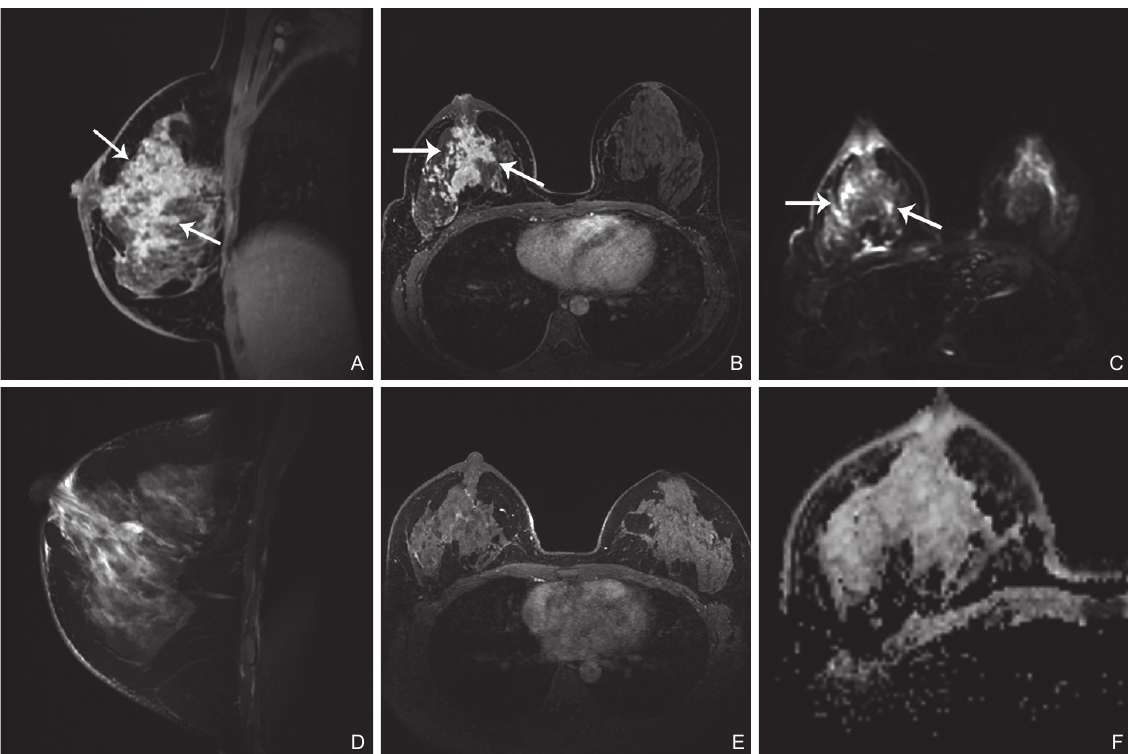
D E Figure 3 A 57-year-old women with multiple right breast lesions that underwent percutaneous biopsy, revealing invasive breast cancer. Before neoadjuvant chemotherapy, CE-MRI (A and B) showed area of clumped enhancement (arrows) with regional distribution, and DWI-MRI (C) showed heterogeneous masses (arrows) of right breast. After completion of neoadjuvant chemotherapy, CE-MRI (D and E) showed no residual enhancement, and DWI-MRI (F) showed no mass of right breast. Pathological examination after surgery confirmed complete pathologic response